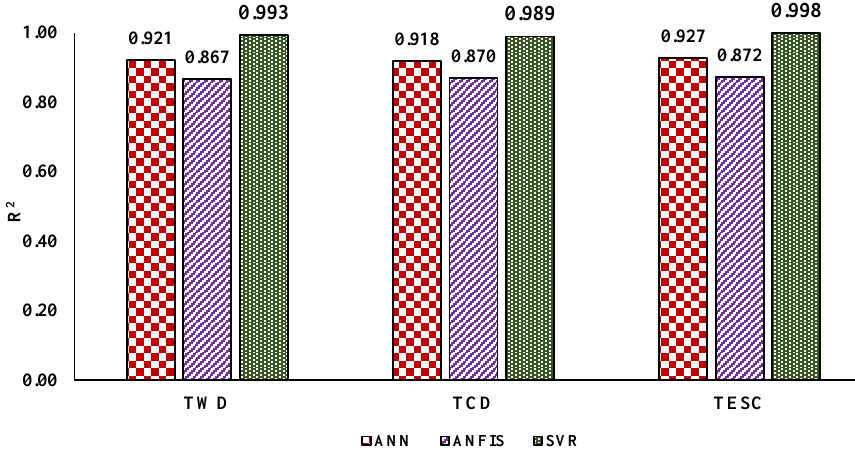
Figure 8. Comparison of modeling accuracies among ML methods. Modeling results indicated that SVR had the highest performance for prediction environmental damages, exegetic categories, and ESC with respect to statistical indicators.